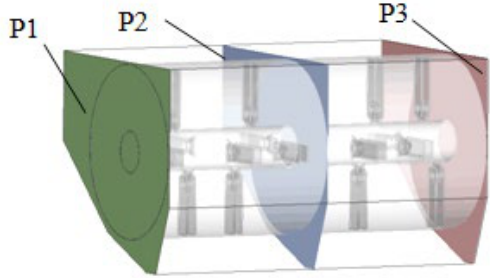
Figure 7. Selection of CC section. Section P1 was located on the left side of the tool axis and passed through the end face of the tool axis; section P2 was located at the center of the tool axis and parallel to the P1 plane; section P3 was located on the right side of the tool axis and passed through the end face of the tool axis.